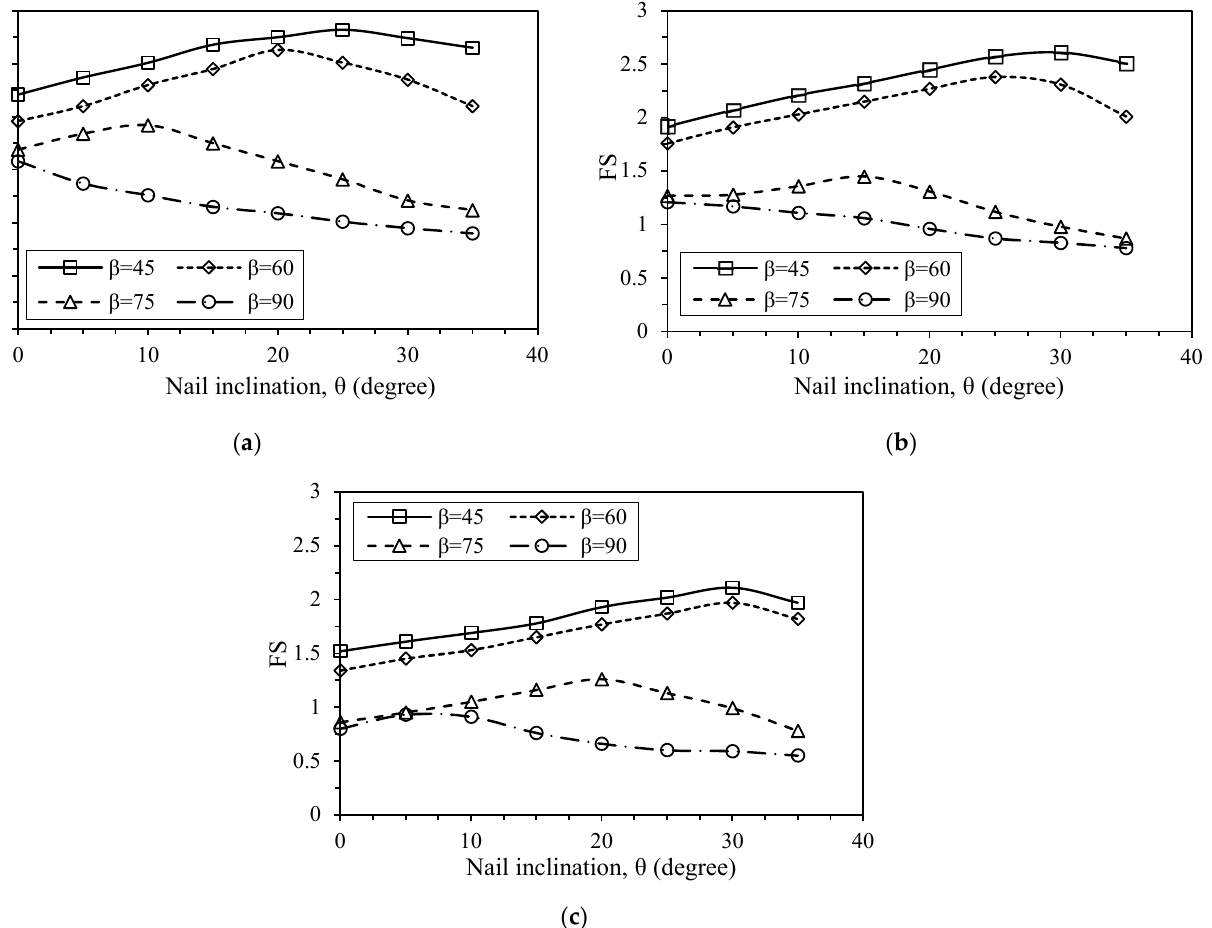
Figure 4. Relationship between factor of safety (FS) and slope angle for different backslopes.